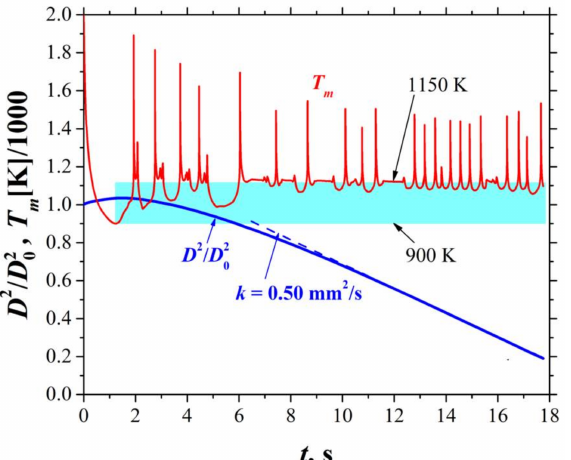
Figure 10. Calculated time histories of the maximum gas temperature, T m , and the normalized squared droplet diameter, D 2 / D 2 , at the forced ignition and combustion of the n-dodecane droplet 0 with D 0 = 2.8 mm and L = 0.55 cm in air at NPT conditions. The blue band envelopes the low- temperature flashes of cool and blue